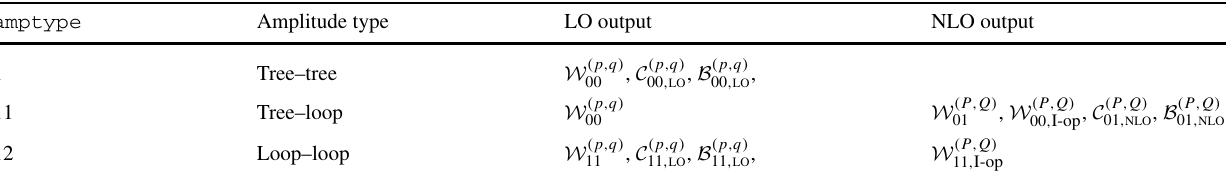
Table 4 Values of amptype to register different types of perturba- tive contributions and corresponding probability densities that can be computed by OpenLoops . Objects of LO and NLO kind are evalu- ated at order α p s α q and α P s α Q , respectively, according to the values